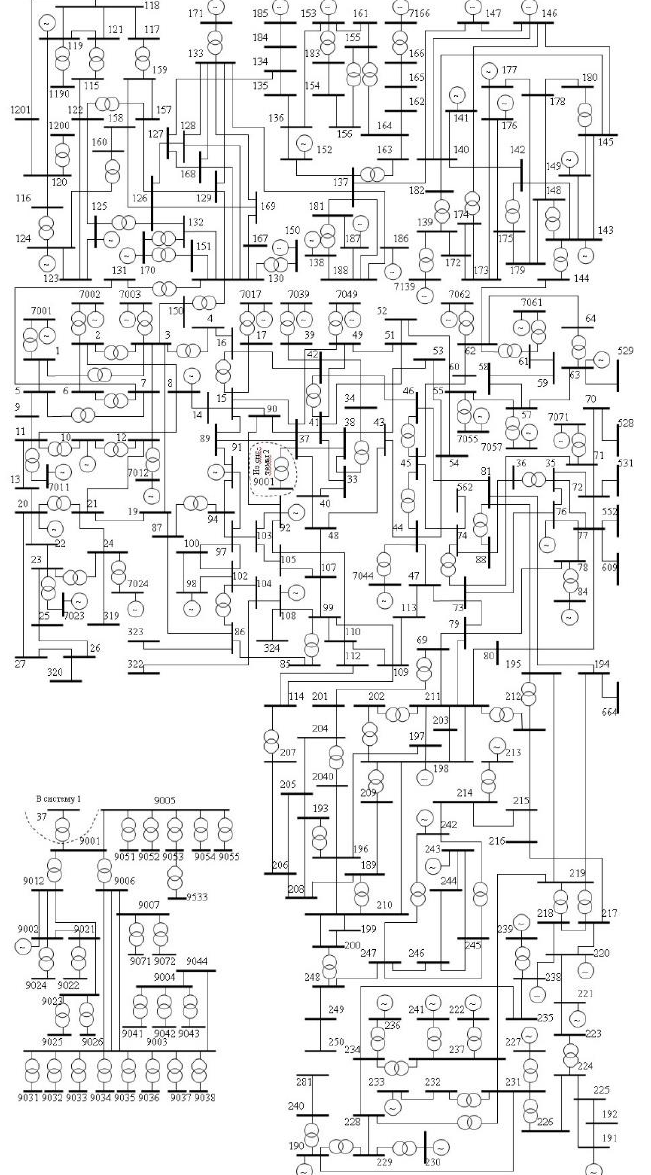
Fig. 16. Diagram of the 300 – bus IEEE